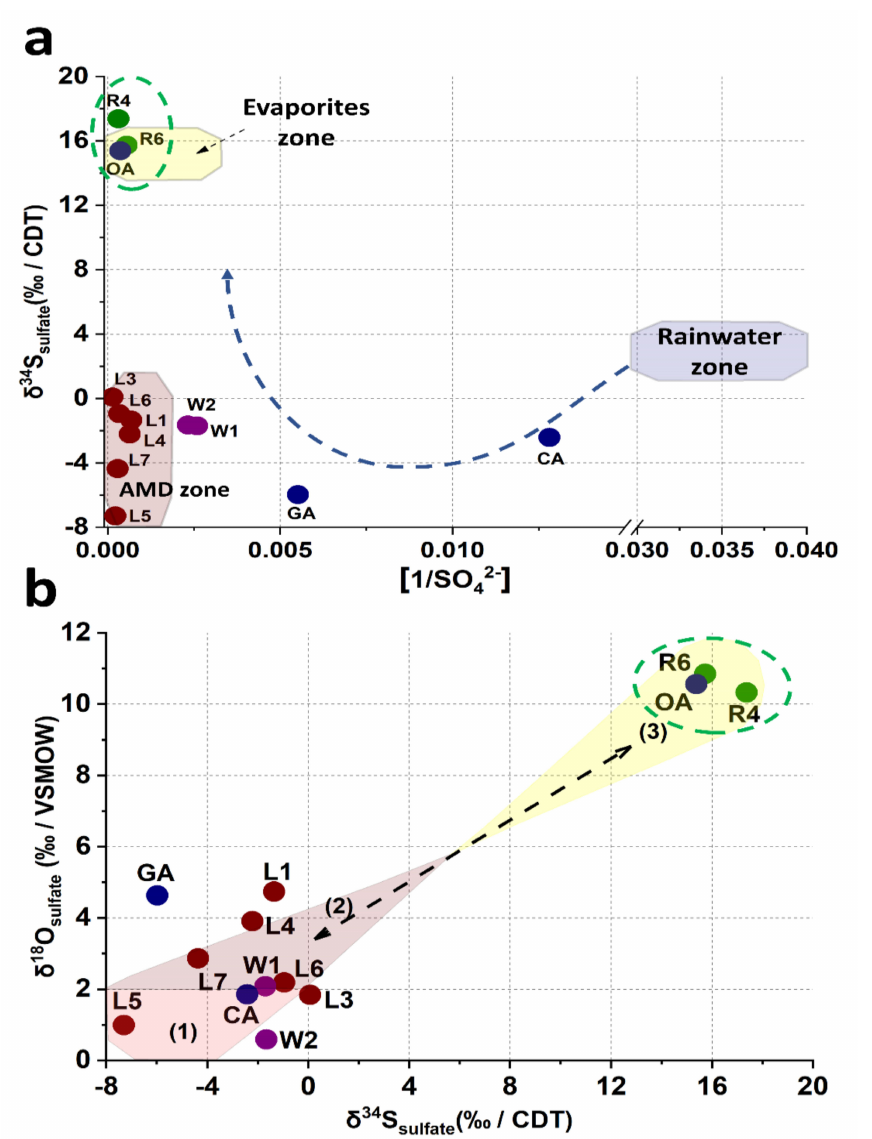
Figure 6. Isotopic analysis. ( a ) δ 34 S sulfate values vs. the 1/[SO 42 − ] ratio showing the rainwater zone and evaporite zones and defining a new zone in this study for water quality associated with AMD produced by sulfide oxidation.( b ) Isotope values of δ 18 O sulfate and δ 34 S sulfate associated with each input and output flux of sulfate. The shadow areas represent the identified processes that correspond to (1) mineral sulfide oxidation, (2) precipitation of sulfate secondary minerals by oversaturation, and (3) old Cretaceous evaporite dissolution from the El Abra